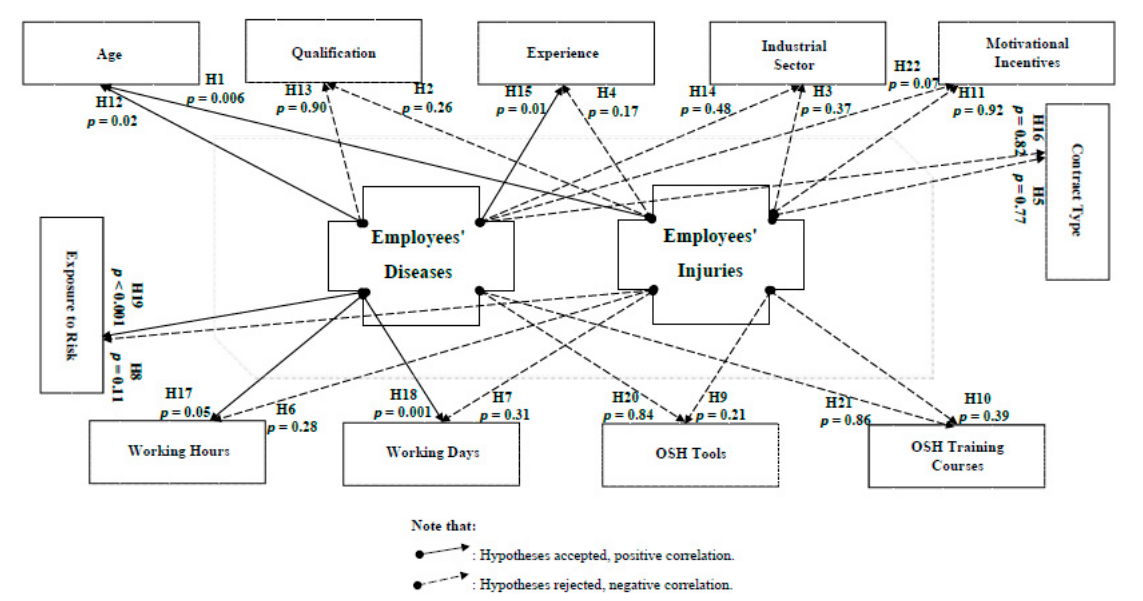
Figure 22. The presentation of case correlation (3) and its hypothesis testing.